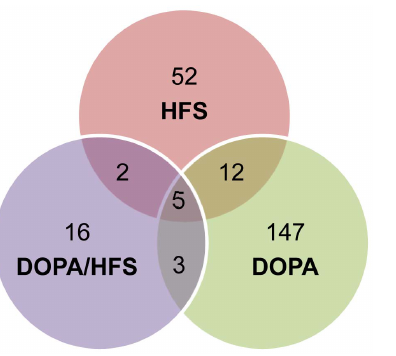
Figure 4. Venn diagram showing the numbers of genes specifically or commonly altered by the